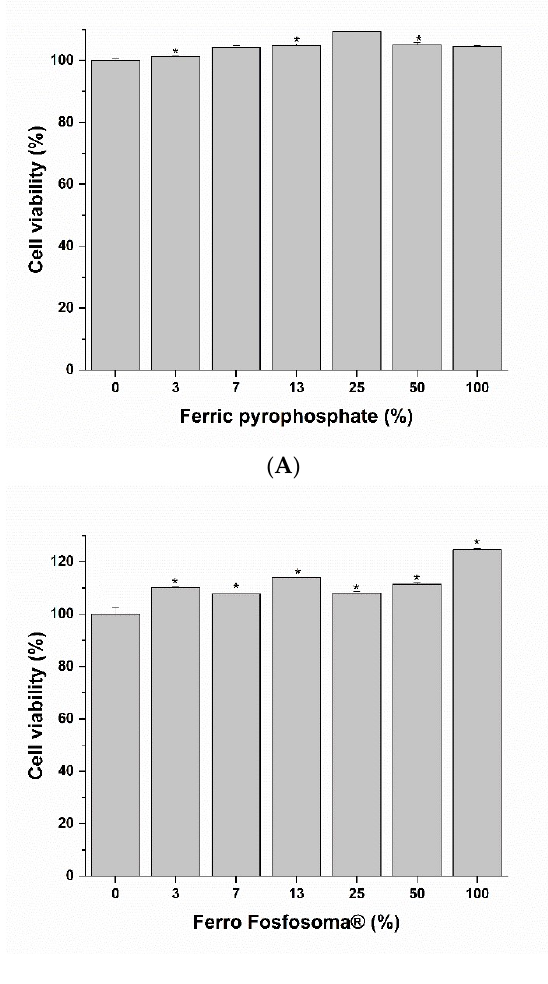
Figure 1. Effect on cell viability of Caco-2 cells. Cells were exposed to increasing concentrations of the bioaccessibile fractions of ferric pyrophosphate ( A ) and Ferro Fosfosoma ® ( B ) for 3 h, and then cell viability was determined using MTS assay. * p < 0.05.